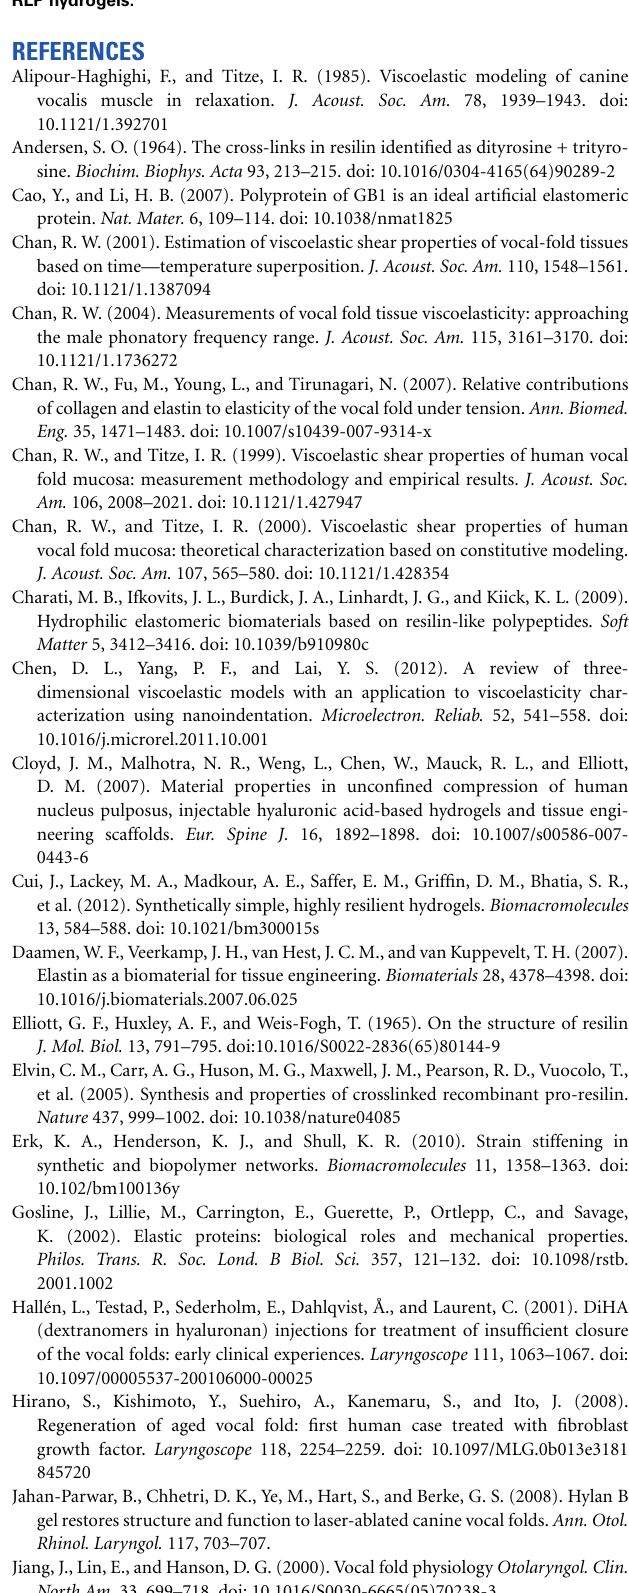
Table S3 | Summary of general properties and resilience values for 20 wt% RLP hydrogels. REFERENCES Alipour-Haghighi, F., and Titze, I. R. (1985). Viscoelastic modeling of